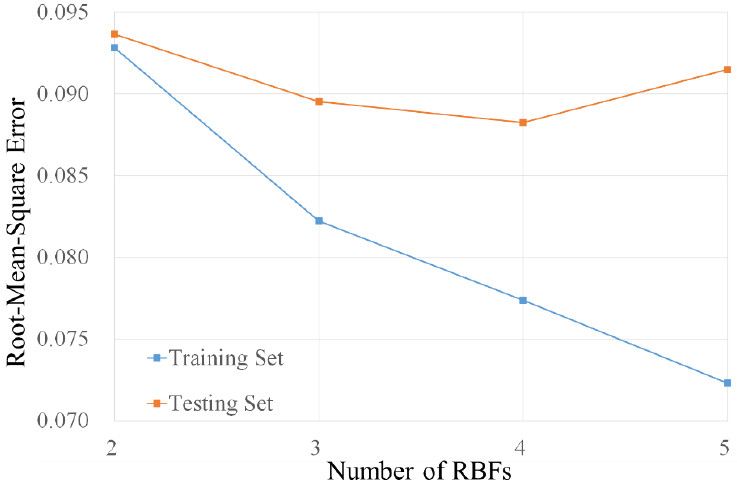
Figure 1. The performance of the trained radial basis functions-artificial neural networks (RBF-ANNs).